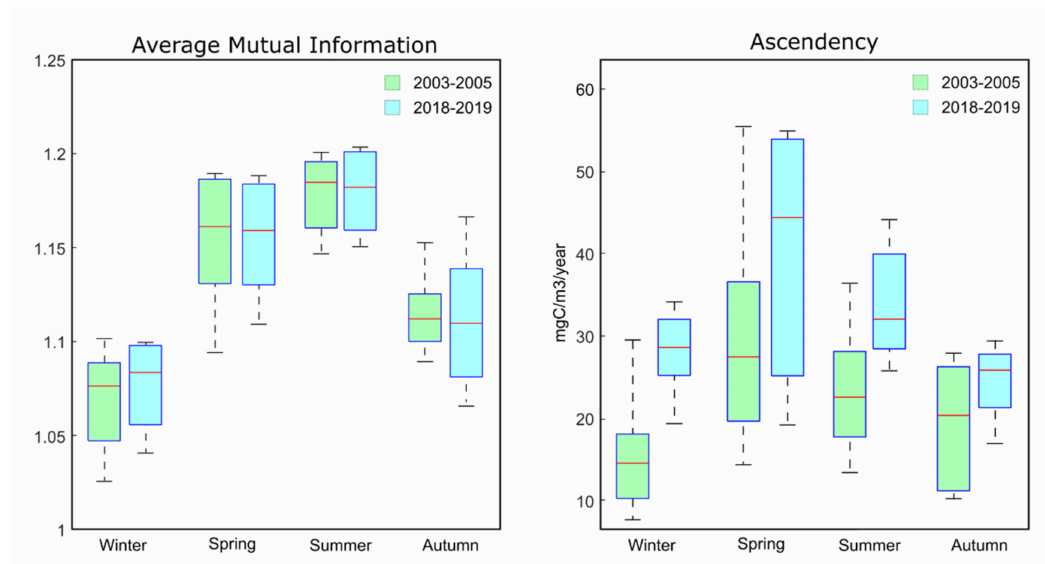
Figure 9. Seasonal Average Mutual Information and Ascendency (mgC/m 3 /year) in the two periods (2003–2005 and 2018–2019).